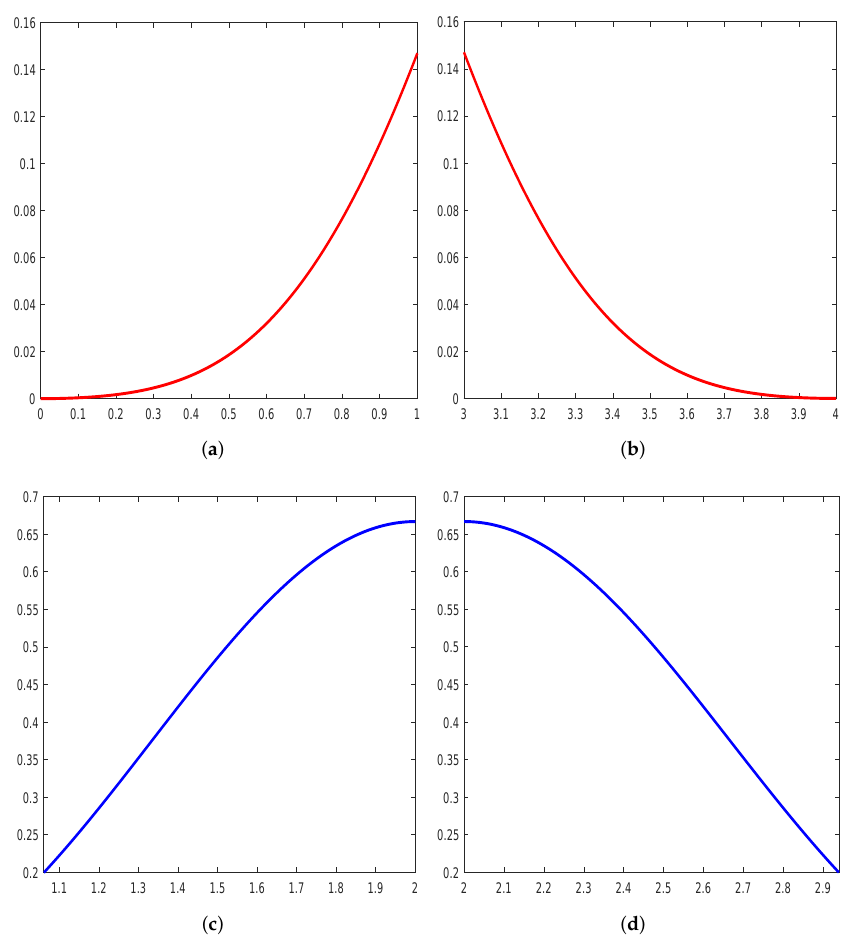
Figure 4. Symmetry of CTBS functions. ( a ) Symmetry of the first function. ( b ) Symmetry of the fourth function. ( c ) Symmetry of the second function. ( d ) Symmetry of the third